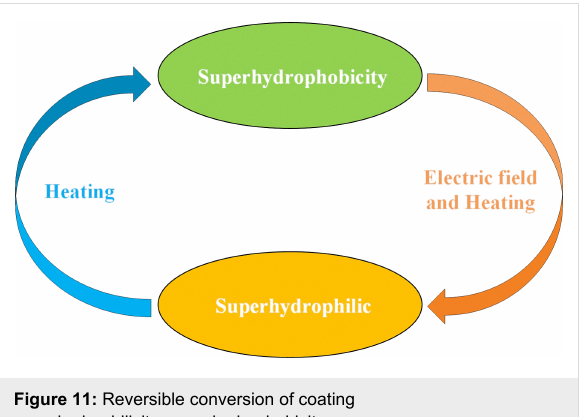
Figure 11: Reversible conversion of coating superhydrophilicity–superhydrophobicity.